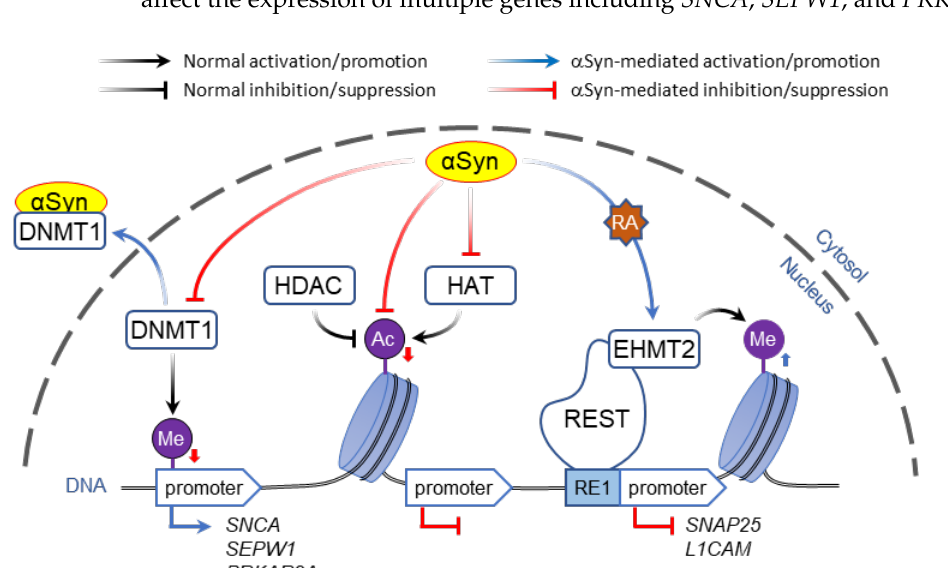
Figure 1. Role of α -Syn in post-translational modification of DNA and histones. α -Syn has been shown to alter PTM of DNA and histones via multiple mechanisms, three of which are shown here. Left, α -Syn can promote the translocation of DNMT1 from the nucleus to the cytosol leading to DNA hypomethylation and increased genes expression. Middle, α -Syn may interact directly with histone 3 or inhibit HAT activity; in both scenarios reduced histone acetylation leads to decreased gene expression, which can be rescued by HDAC inhibitors. Right, α -Syn may change histone methylation by activating EHMT2 in a retinoic acid (RA)-dependent manner, thus decreasing the expression of genes regulated by REST complex. Arrows next to PTM sites show the effect at higher levels of α -Syn.